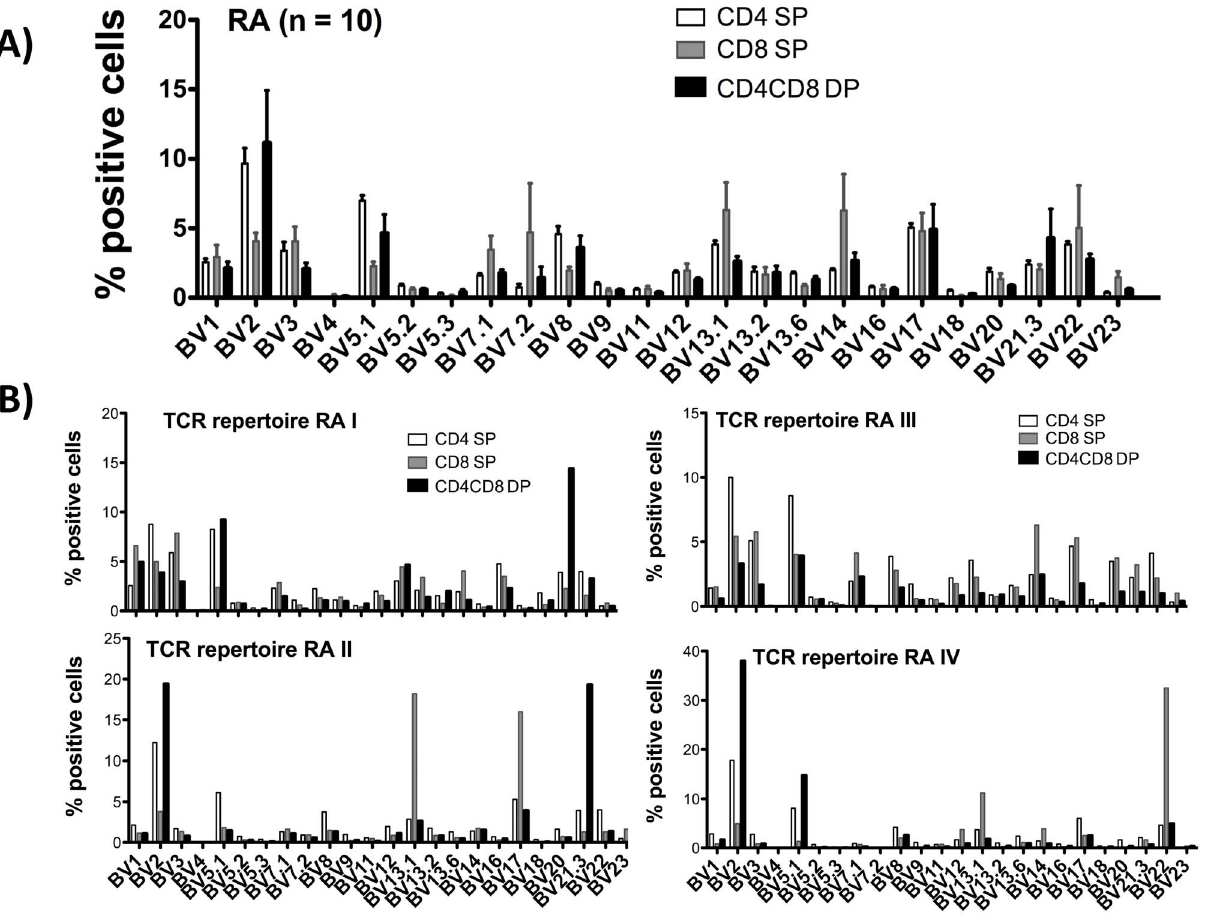
Figure 3. TCR BV distribution in CD4CD8 double positive T cells of RA patients. PBMC from RA patients were isolated and FACS analyses from live cells were performed (PI staining used for exclusion of dead cells). CD3 pre-gated cells were further gated on CD4 single, CD8 single and on CD4CD8 double positive T cells. Bar charts depict the percentage of cells positive for each BV element in the indicated T cell subpopulations investigated. A) Mean distribution of 24 TCR BV elements in peripheral blood T cells from 10 RA patients. B) Examples of the individual distribution of 24 TCR BV elements in 4 RA patients.